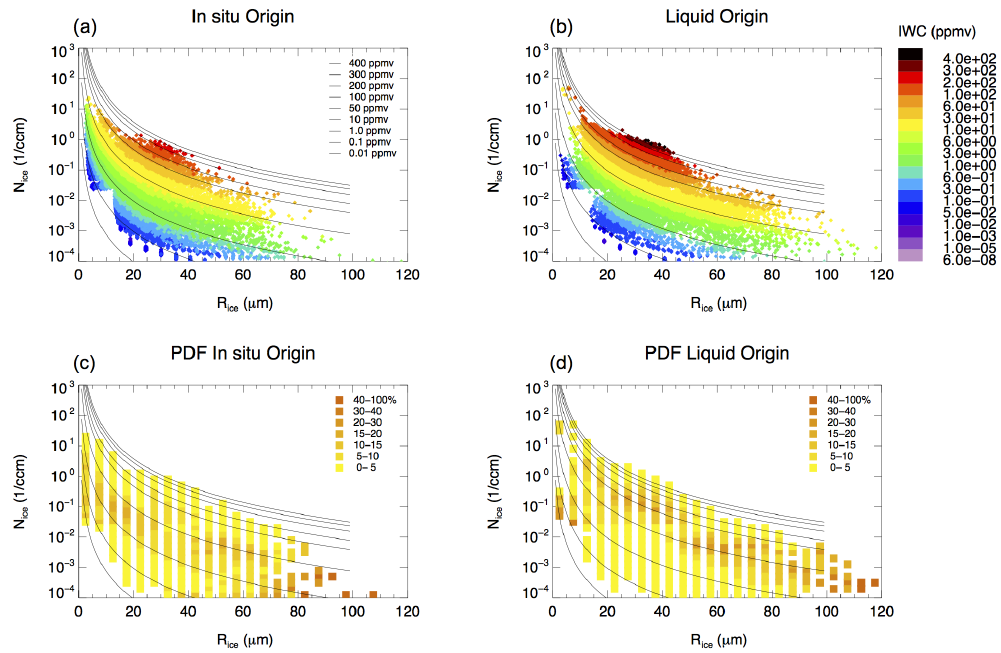
Figure 7. N ice as a function of R ice sorted by observed IWC. The solid black lines in all panels represent IWC levels as calculated by Eq. (2). (a, b) The colors indicate the IWC (in ppmv) that were observed for each observed N ice – R ice combination. (c, d) The colors indicate the frequency of observation for each N ice – R ice combination. The cutoff at small R ice and N ice < 0 . 03cm − 3 represents the lower N ice detection limit of the CAS-DPOL when it is operated at 1Hz. Panel (a) is also shown in Krämer et al. (2016).